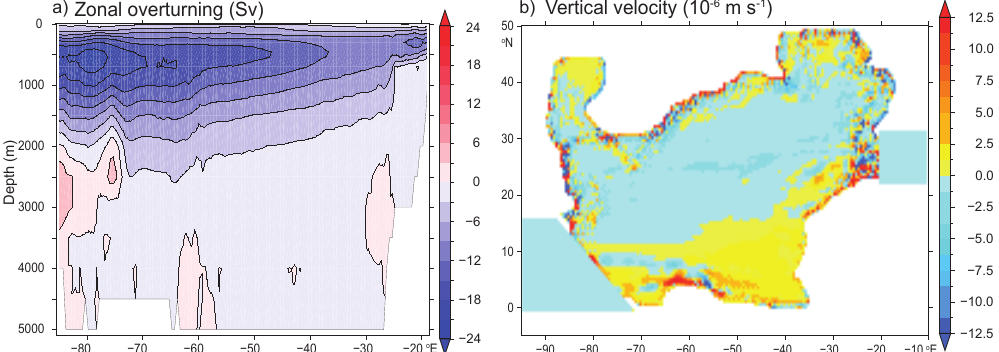
Fig. 2. (a) Zonal overturning for the proto-North Atlantic during OAE2 (21Sv) as calculated by Topper et al. (2011). Contour lines are drawn every 3Sv. Negative values are anticlockwise velocities. (b) Vertical velocities at a depth of 100m during OAE2; the strongest upwelling region is located in the southern proto-North Atlantic, followed in decreasing order by the north-west, north-eastern and northern coast. Note that longitudes are shifted following Topper et al.